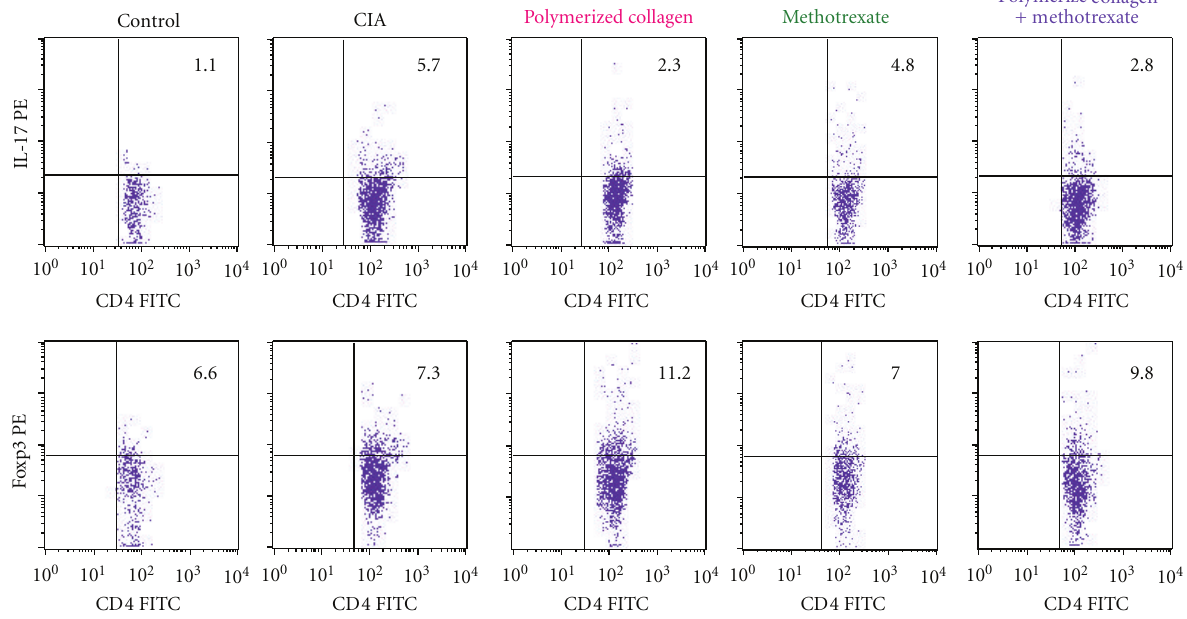
Figure 3: Representative flow plots of IL-17A- and Foxp3-expressing CD4 + T